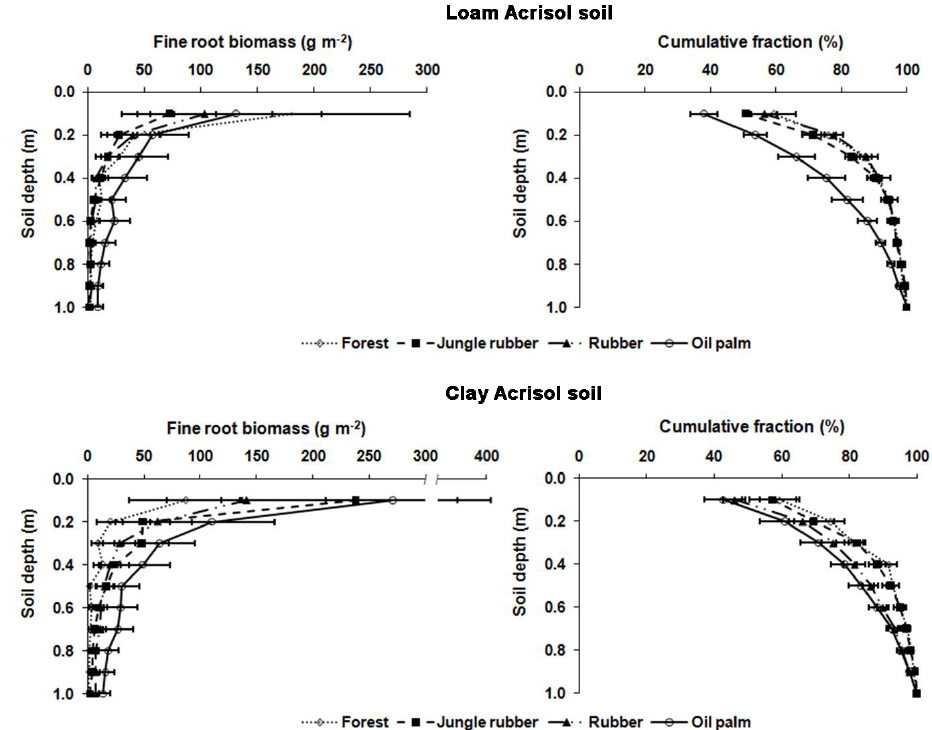
Figure B1. Fine root biomass (gm − 2 ) and distribution (%) down to a depth of 1m in different land uses within the loam and clay Acrisol soils in Jambi, Sumatra, Indonesia. The root measurement was conducted in each replicate plot by digging a pit (1m × 1 . 5m × 2m of depth) at a distance of 2.5m from an oil palm or a tree with a diameter at breast height of ≥ 10cm. Root masses were sampled using a metal block (20cm × 20cm × 10cm) at a depth interval of 10cm from the top down to 1m. Roots were carefully separated from the soil by washing over a 2mm mesh screen and the fine roots were collected in a basin placed underneath the mesh screen. The roots were categorized into fine roots ( ≤ 2mm diameter) and coarse roots (>2mm diameter), dried in an oven at 70 ◦ C for 5 days, and